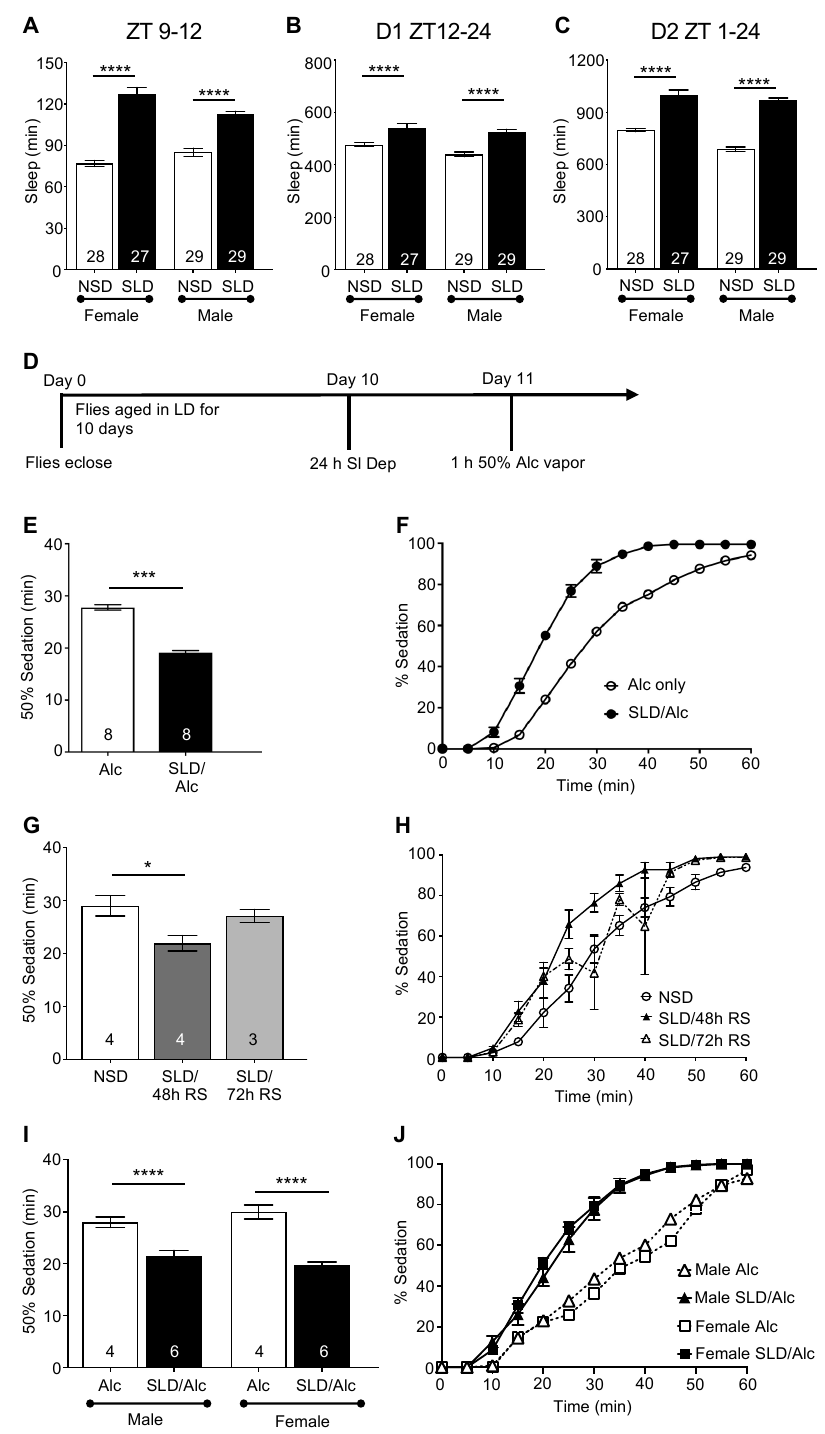
Figure 1. Acute sleep deprivation increases sensitivity to alcohol-induced sedation ( A – C ). Comparison of sleep profiles between 10 d wild-type sleep-deprived (SLD) and non-sleep-deprived (NSD) CS flies housed in LD cycles. Compared to NSD flies, both male and female SLD flies exhibited significantly increased quiescence immediately following the end of the sleep deprivation protocol (( A ), ZT 9-12 [ANOVA: F 3,108 = 52.55, p < 0.0001]; * indicates significant differences between NSD and SLD male and female flies as calculated by Bonferroni post hoc analysis; * p < 0.05, *** p < 0.001, **** p < 0.0001), as well as during the 12 h dark cycle (( B ), D1 ZT 12-24 ANOVA: F 3,108 = 21.16, p < 0.0001) and the